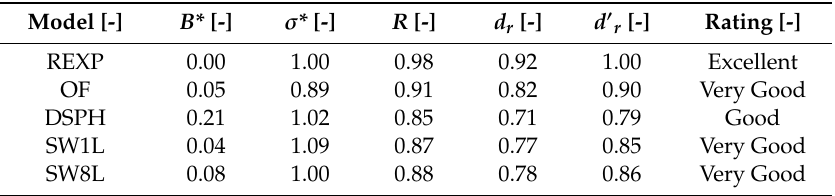
Table 2. Model performance and pattern statistics evaluated for η of REXP, OF, DSPH, SW1L and SW8L at measured location WG14 (dike toe location). Adapted from the work in [3], with permission